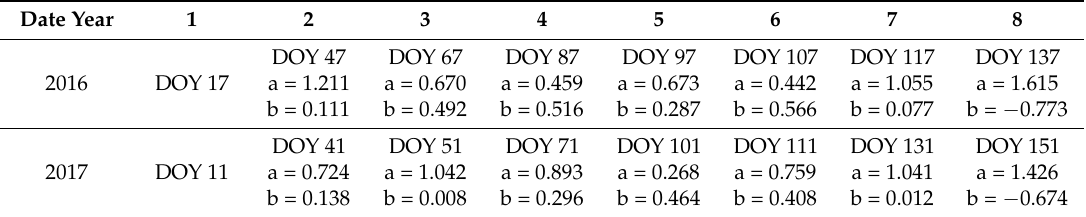
Table 3. Slope (a) and interception (b) deduced from the already produced linear equations.